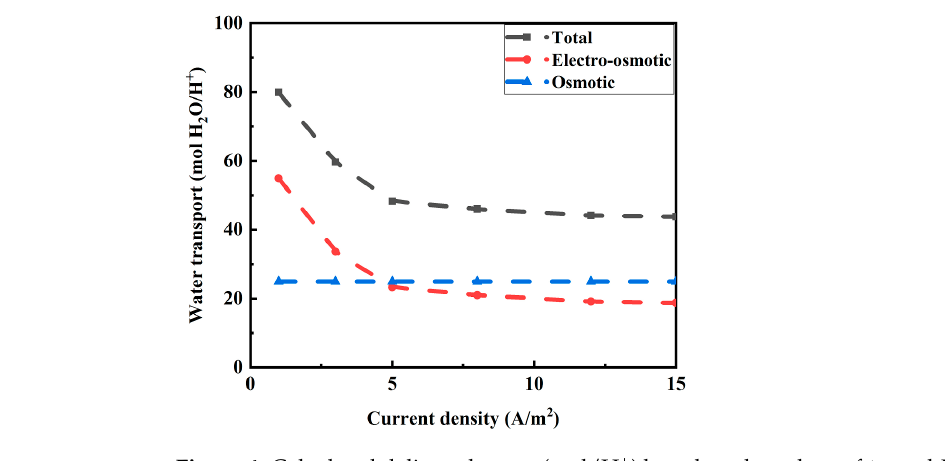
( b ) Figure 6. Water profiles in the FO membrane for four osmotic pressures when the circuit was held open. The negative electrode is on the left, and the net water flux moves from right to left ( a ). Profiles of the membrane water content for different membrane thicknesses ( b ). 3.2.3. Water Content of Different Membrane Thicknesses Four membrane thicknesses were compared when the current density of the OsMFC was 0.2 Am − 2 and the osmotic pressure was 43 atm. Figure 6b shows that the higher the